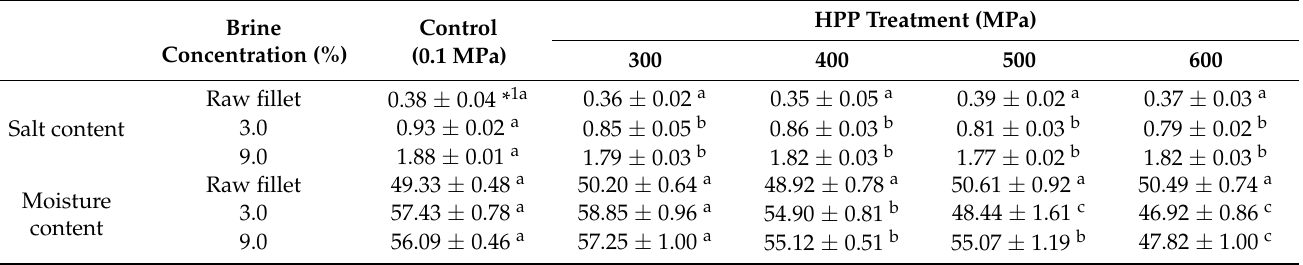
Table 6. The salt and moisture contents (%) of mackerel fillets after the brine salting of 3.0%